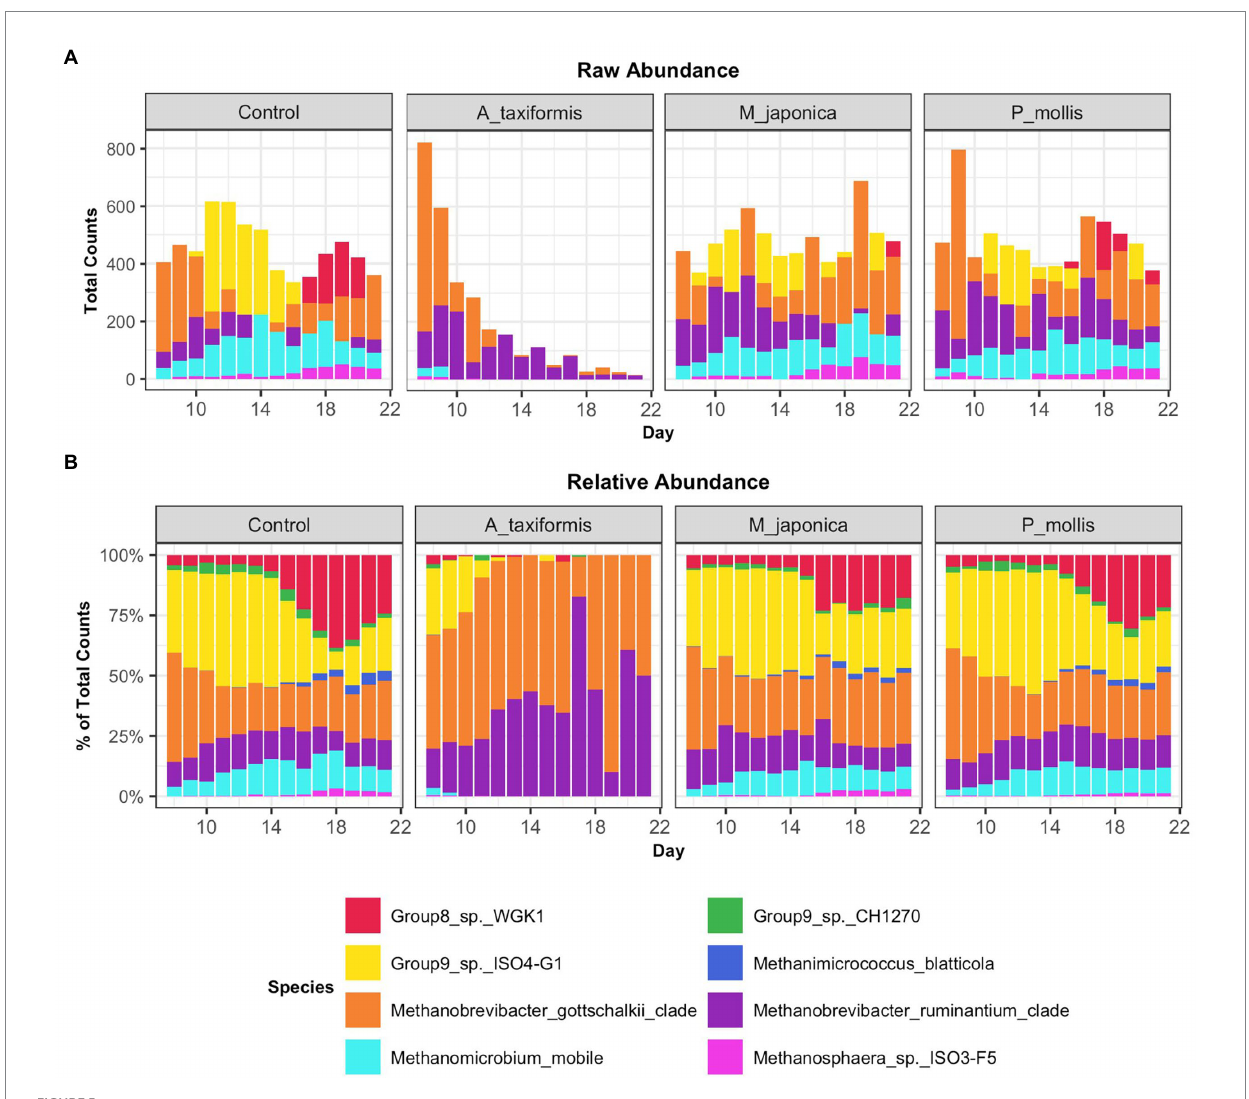
FIGURE 5 Raw (A) and relative (B) abundances of methanogenic species across all treatment groups. Values are the daily median across all